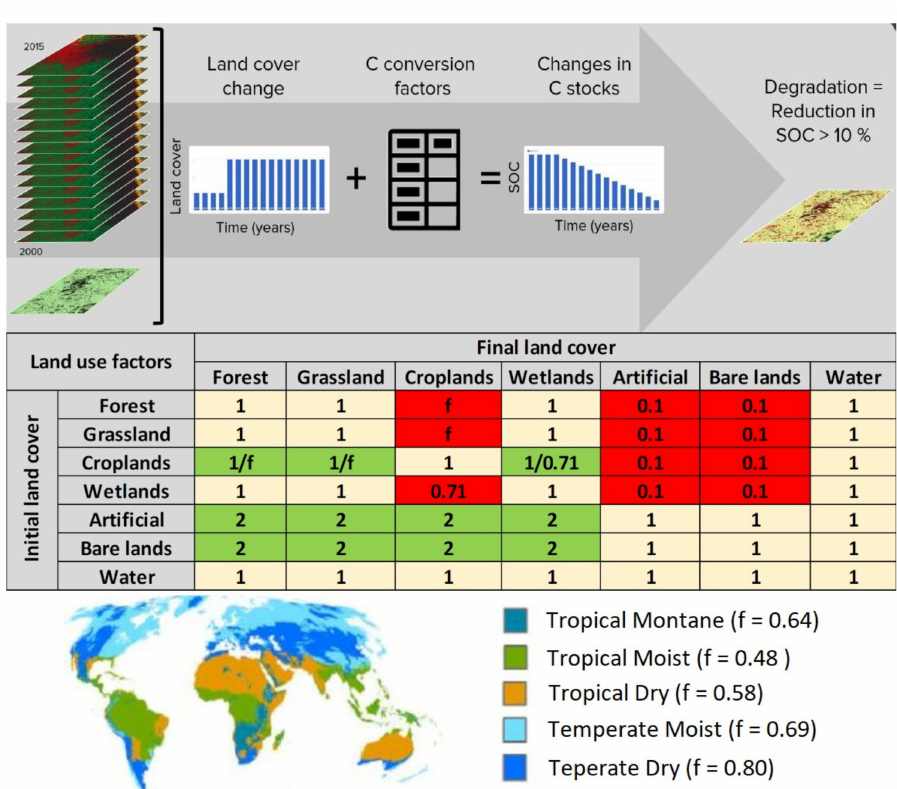
Figure 1. The methodology for the SOC evaluation metric. Carbon change relation to land degra- dation ( up ) and conversion factors with different satellite image colours ( down ). The parameter f converts C emissions to C stock changes, according to the international database of the routine Trends.Earth, in line with the IPCC’s guidelines. Source: Adapted from [22].